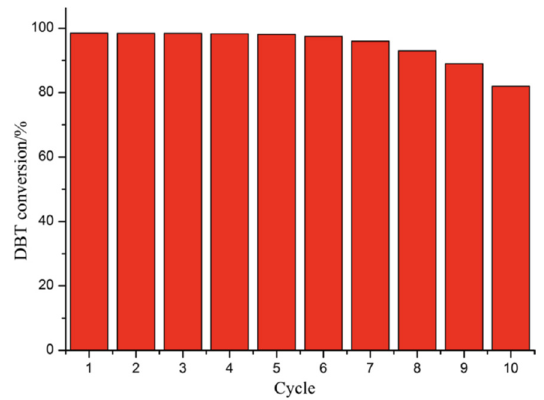
Figure 8. Stability test results of the catalyst [80].